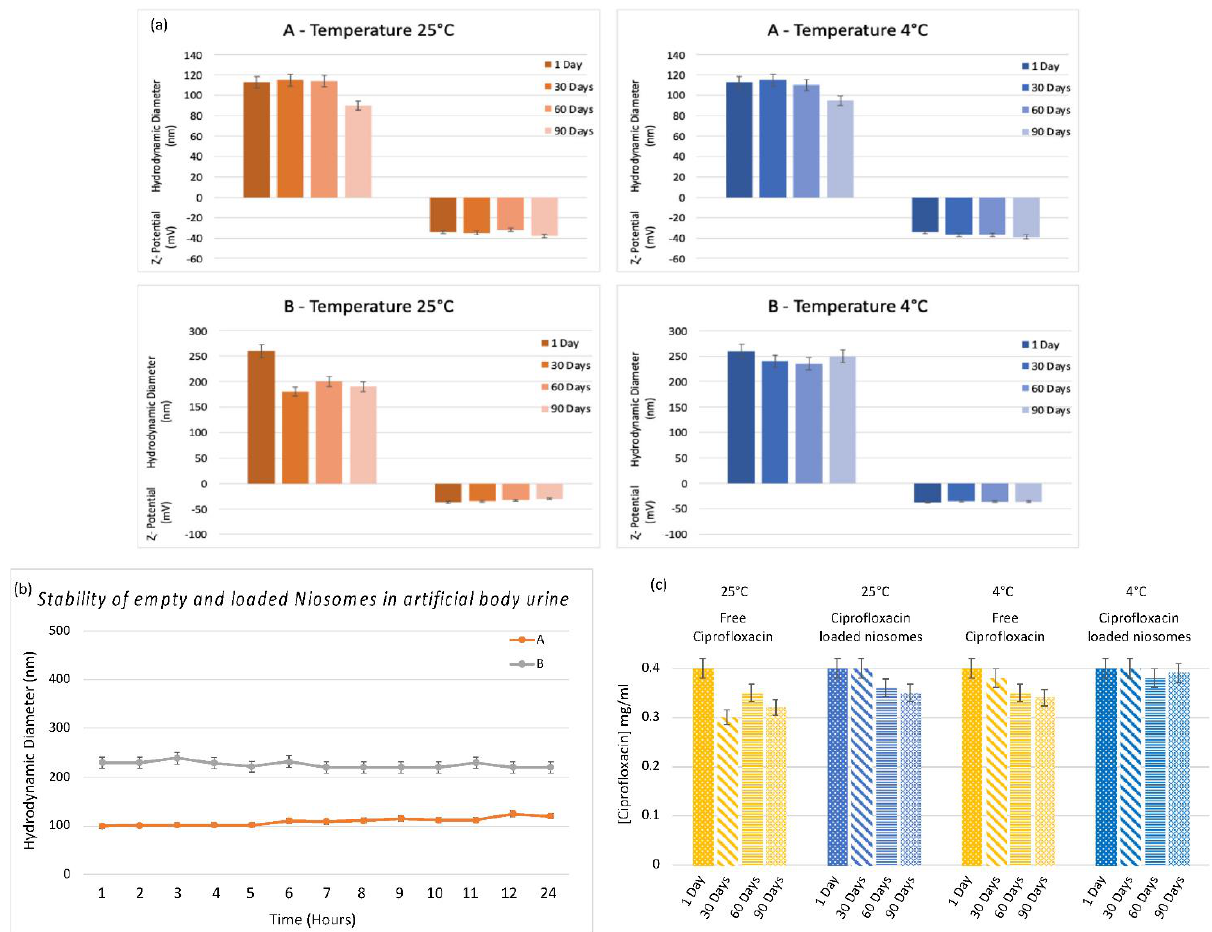
Figure 3. ( a ) Result of investigation on physicochemical stability of empty niosomes (A) and CIP- loaded niosomes (B) in terms of hydrodynamic diameter and ζ -potential until up 90 days at 4 °C and room temperature. ( b ) Stability studies in the presence of artificial body urine, following variation of hydrodynamic diameter and ζ -potential values of CIP-loaded niosomes; Pre-exp values refer to CIP-loaded niosomes before the presence of artificial body urine. ( c ) Stability studies over time of free CIP and CIP-loaded into niosomes at two different storage temperatures over a 90-day